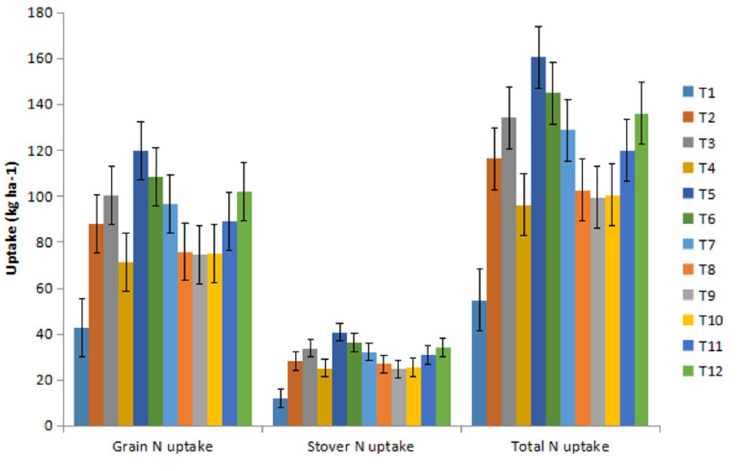
Fig 1. Nitrogen uptake in chickpea under various INM modules.